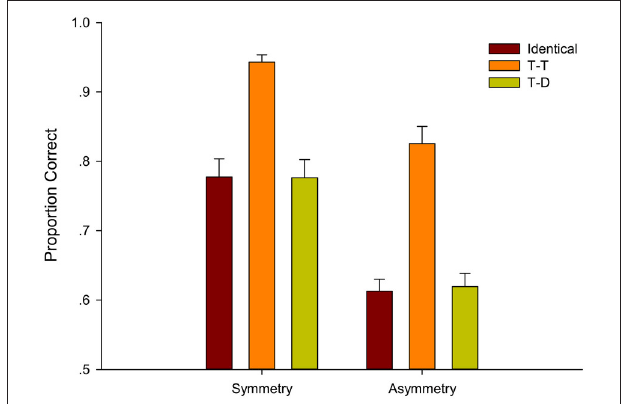
FIGURE 7 | Average proportion correct and standard error for six conditions classified by groupings based on symmetry and color in Experiment